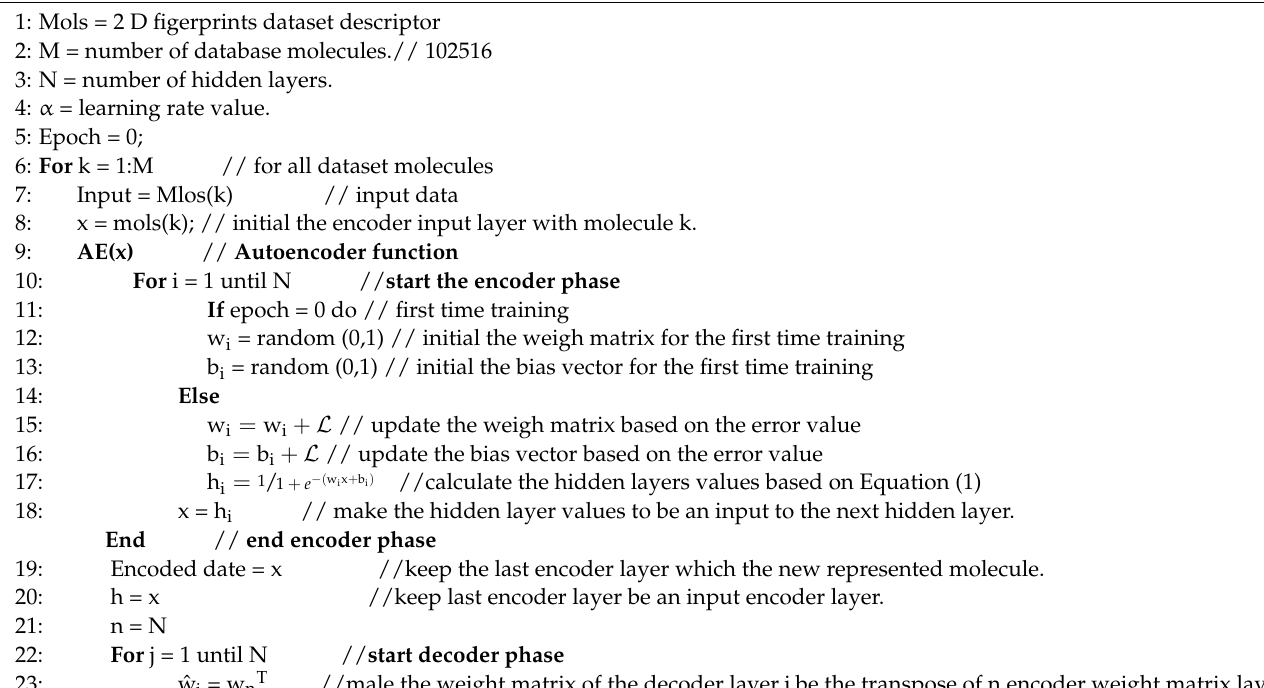
Algorithm 1: Autoencoder Algorithm. The Pseudocode of the proposed Autoencoder algorithm for 2D molecular